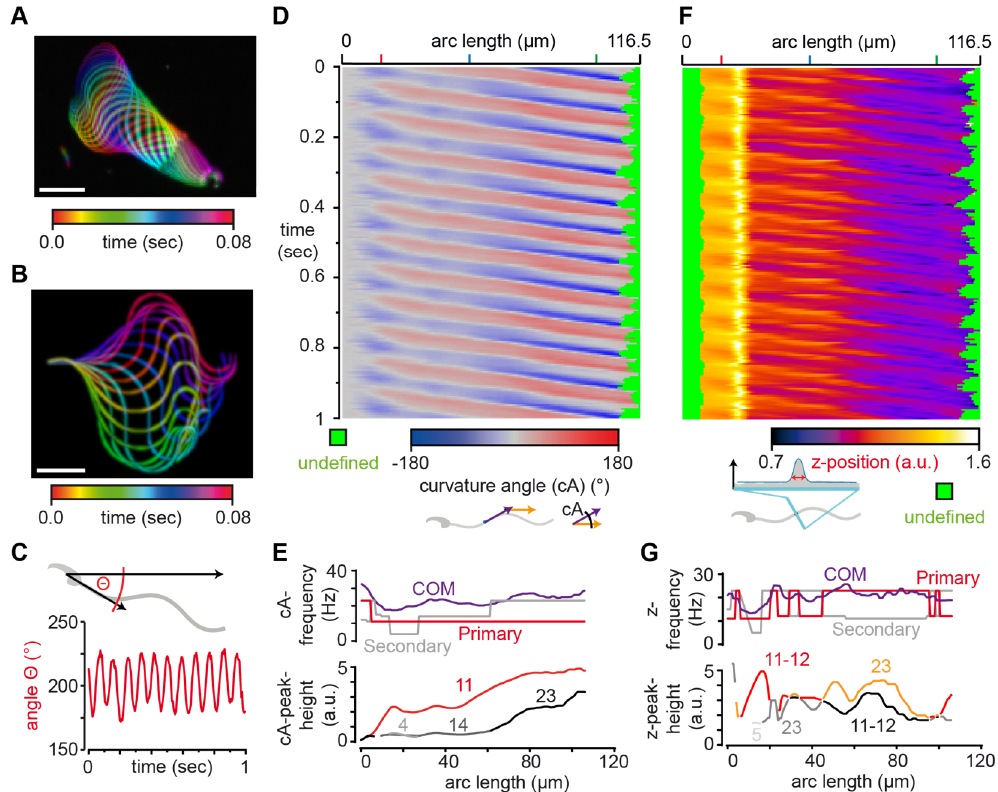
Figure 4. SpermQ reveals the beat pattern of a head-tethered mouse sperm. SpermQ analysis of a wild-type mouse sperm tethered to a glass surface at the head. Projection of the raw image ( A ) and the trace after orientation to the head midpiece axis ( B ), each representing one beat cycle; ( C ) SpermQ analysis reveals that the head orientation angle Θ stably oscillates with a primary frequency of 11 Hz around an angle of 200° in space (center of mass (COM) of frequency spectrum: 19.9 Hz; ( D ) kymographs of the determined curvature angle (cA) or ( F ) the z-position relative to the plane; ( E ) SpermQ frequency analysis of the cA or ( G ) of the z-position along the flagellum. Amplitudes for selected peaks in the frequency spectrum (frequency values indicated in Hz) are plotted in the bottom graph. Scale bars: 20 µm.